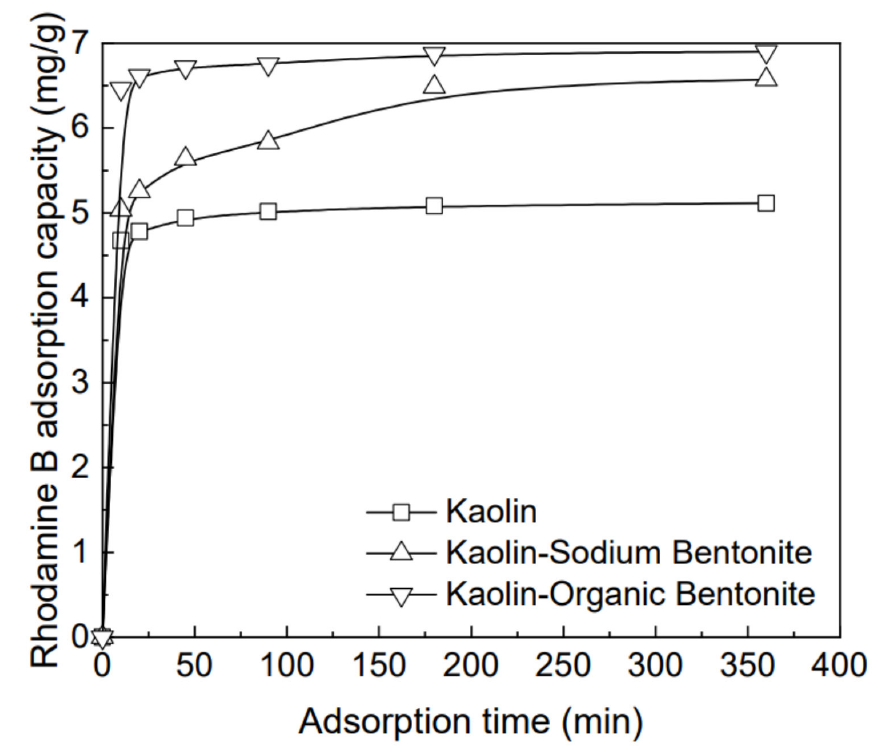
Figure 4. Variation of adsorption amounts of different adsorbents for the rhodamine B solution, with an initial concentration of 200 mg/L versus adsorption